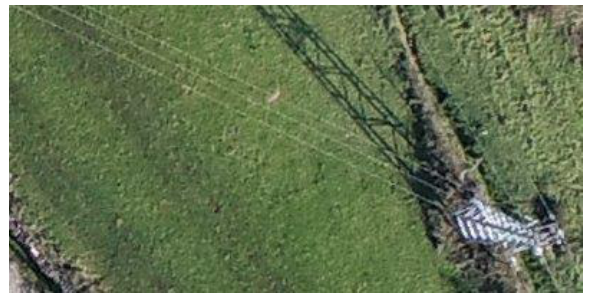
Figure 2. Example of a high voltage pole and lines in the image with GSD of 9